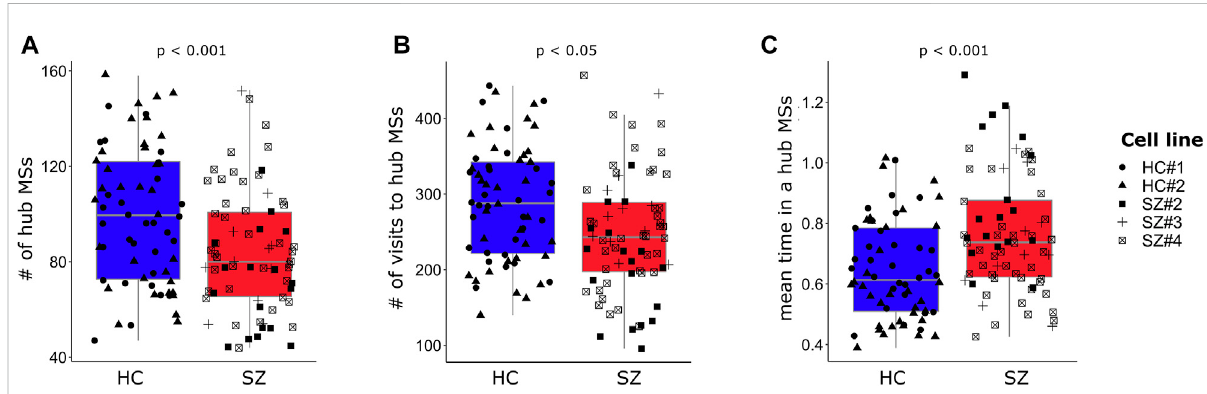
FIGURE 6 SZnetworksvisitalowernumberofdifferenthubMSsbutremainlongeruninterruptedtimeinthem. (A) ThenumberofdifferentvisitedhubMSs islowerinSZnetworks. (B) SZnetworksvisithubMSslessoftenthanHCnetworks,but (C) spendlongeruninterruptedtimeinthesamehubMS.Each single data is plotted independently on the boxplots and its symbol indicates the cell line of the particular network. For each dependent variable ( Y -axis), the p -value ( p ) associated with the SZ effect from the regression model (Supplementary Table S3) is indicated. A time-window of width = 70 frames (~10.5 s) was used for capturing the visited hub